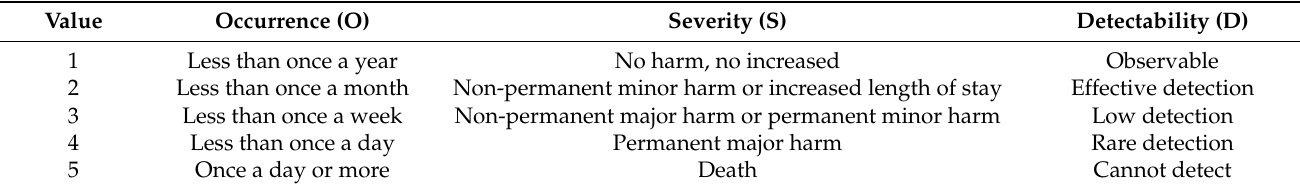
Table 1. Likelihood of occurrence, severity, and detectability parameters.